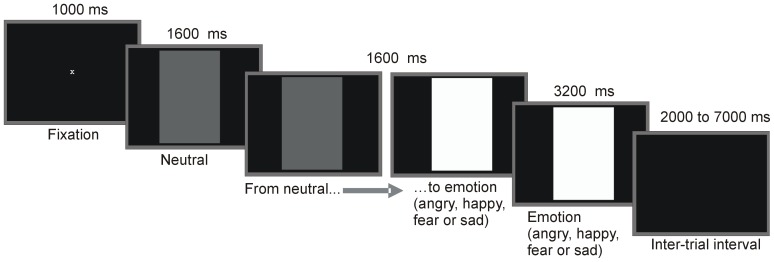
Example trial of the passive viewing task.Each trial started with a central fixation cross, followed by a film clip. The clips started with a neutral expression (in the figure represented by a gray rectangle), followed by a morph into a dynamic emotional expression and ended with a still of the full-blown emotion (in the figure represented by a white rectangle). Each trial ended with an inter-stimulus interval.